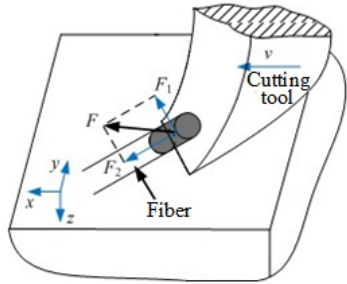
Figure 8. Analysis of a single fiber cutting force when fiber orientation angle is 0 ◦ .